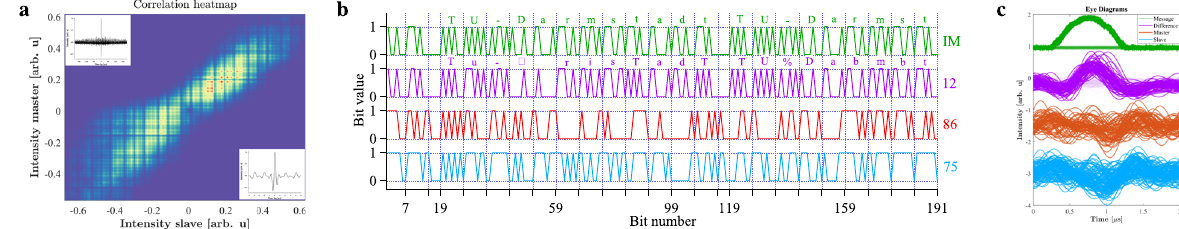
Fig. 3 Private communication with chaos anti-synchronization. a 2D and 1D (insets) correlation diagrams for the fi ltered intensity of the slave and the master QCL. The fi ltered signal of the slave laser was fl ipped so that the 1D correlation diagram has a maximum value of 1 and the 2D correlation diagram shows a positive correlation (instead of − 1 and negative correlation, respectively). b Bit series for the initial message (IM in green), the difference (in purple), the master ’ s signal (in red), and the slave ’ s signal (in blue). Except for the initial message, the number of errors is written on the right side of the bit series, with the corresponding color. The translation of the difference bit signal is also displayed by comparison with the initial message. The private mid- infrared transmission achieves a BER of 6%, which corresponds to 12 errors out of 191 bits. c Experimental eye diagrams for the four time traces displayed